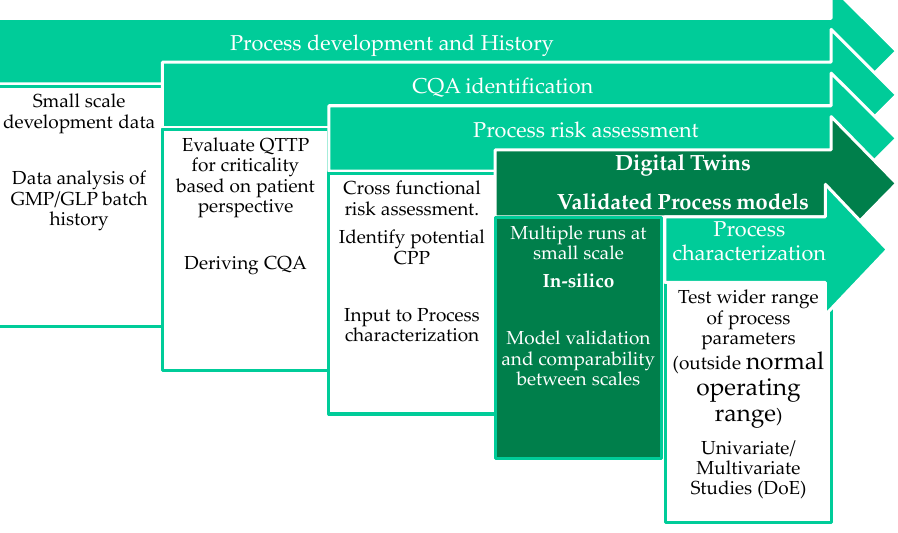
Figure 3. Physico-chemical process model in process development adopted from [39].